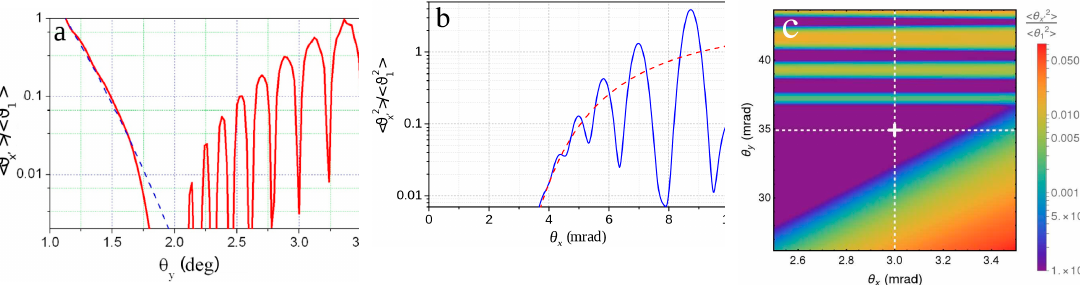
Figure 1. Dependence of multiple scattering mean square angle on in incidence angle θ y w.r.t. the Si ‹001› axis at θ x = 3 mrad ( a ); on that of θ x w.r.t. the Si (110) plane at θ y = 34.9 mrad (2 є ) ( b ) and on both θ x and θ y ( c ), in units of ‹ θ 12 ›, corresponding to the maximum incoherent scattering